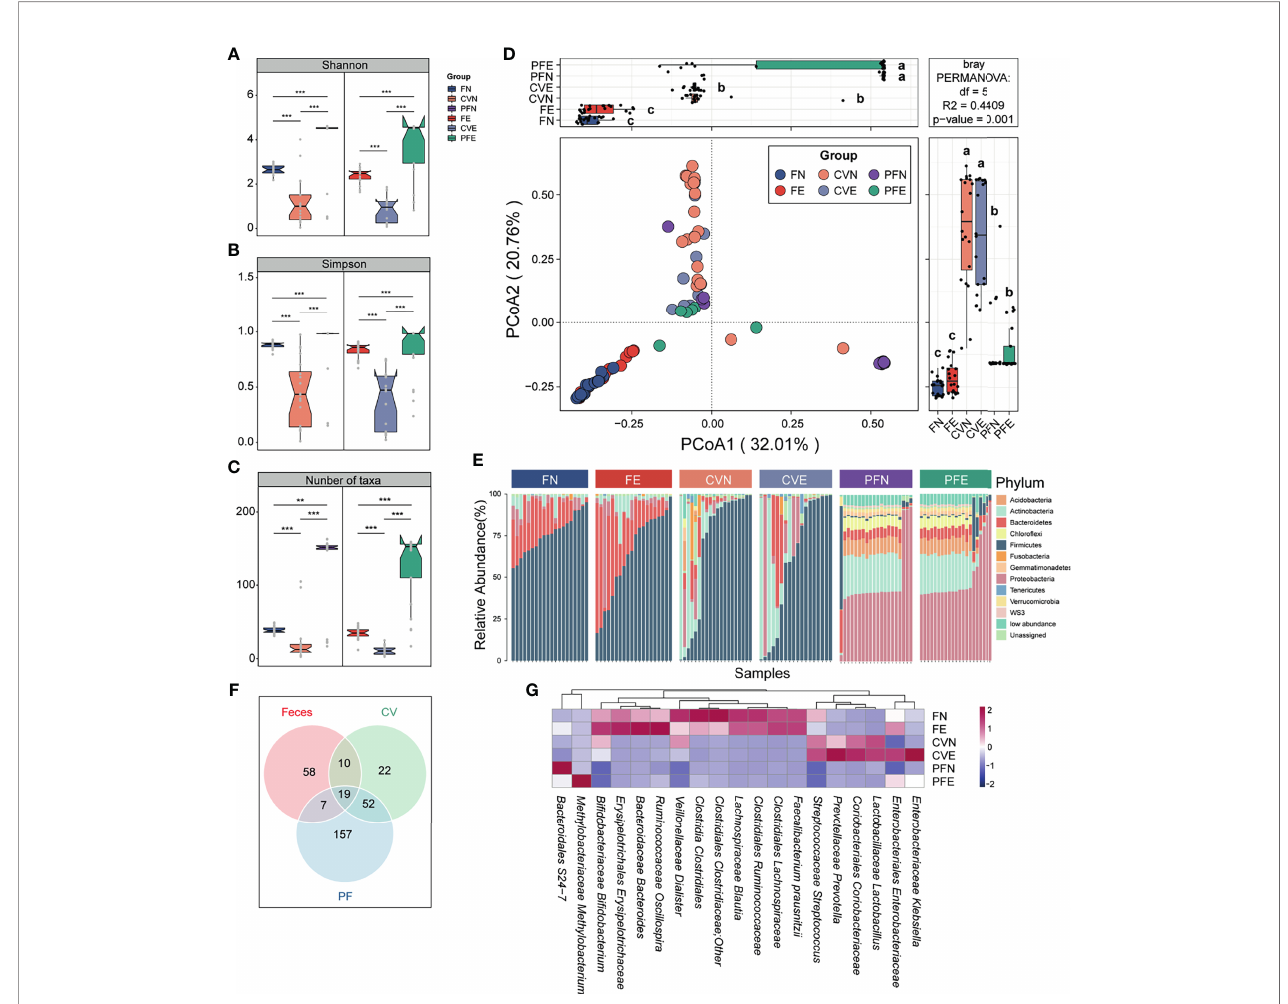
FIGURE 2 | Microbiota composition was distinct between different body sites. (A – C) Comparison of the a diversity based on Shannon diversity, Simpson index, and number of taxa after decontamination in different body sites of controls and EM subjects. Statistical signi fi cance was determined by the Mann – Whitney U test. **p < 0.01, ***p < 0.005. (D) The PCoA was assessed using the Bray – Curtis dissimilarities matrix based on microbiota at the species level (mean relative abundance > 0.1%; prevalence > 10% individuals). Different letters (a, b, c) indicate signi fi cant differences (p <0.05) between six groups according to the least signi fi cant difference (LSD). Changes in microbiome composition were assessed with permutational analyses of variance (PERMANOVA, R2 = 44.09%, p = 0.001), indicating that the largest variance in the microbiota was at the body sites level. (E) Cumulative bar charts of the most abundant taxa at the phylum level. Samples are ordered according to increasing relative abundances of the most abundant phylum within each group. (F) Venn diagram shows the number of commensal bacteria across different body sites. (G) Heatmap displays 19 taxa shared by different body